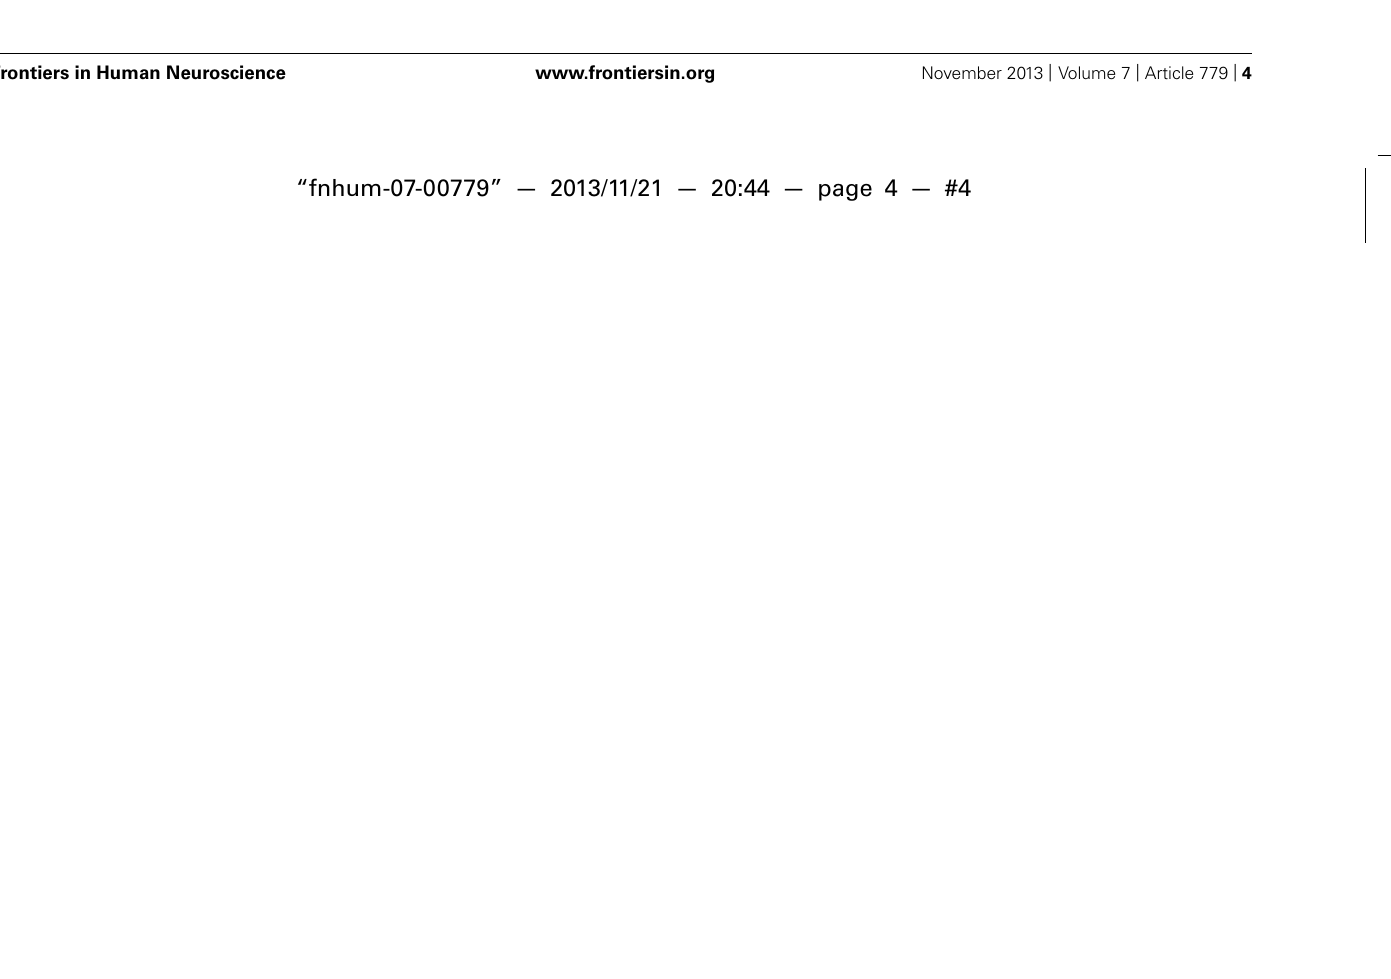
blue squares) were placed on the (A) and (B) forehead scalp region, which corresponded to AF7/8, F5/6, F3/4, and AF3/4 EEG channels (international 10/10 system), respectively renamed left/right channels 1, 2, 3, and